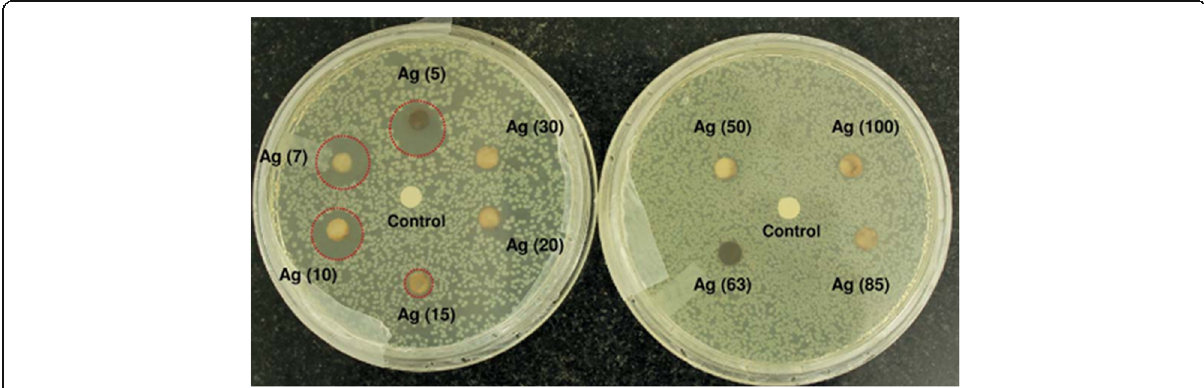
Fig. 12 Disk diffusion tests for different-sized silver nanoparticles against the E. coli MTCC 443 strain. The zone of inhibition is highlighted with a dashed circle indicating a noticeable antibacterial effect [60]